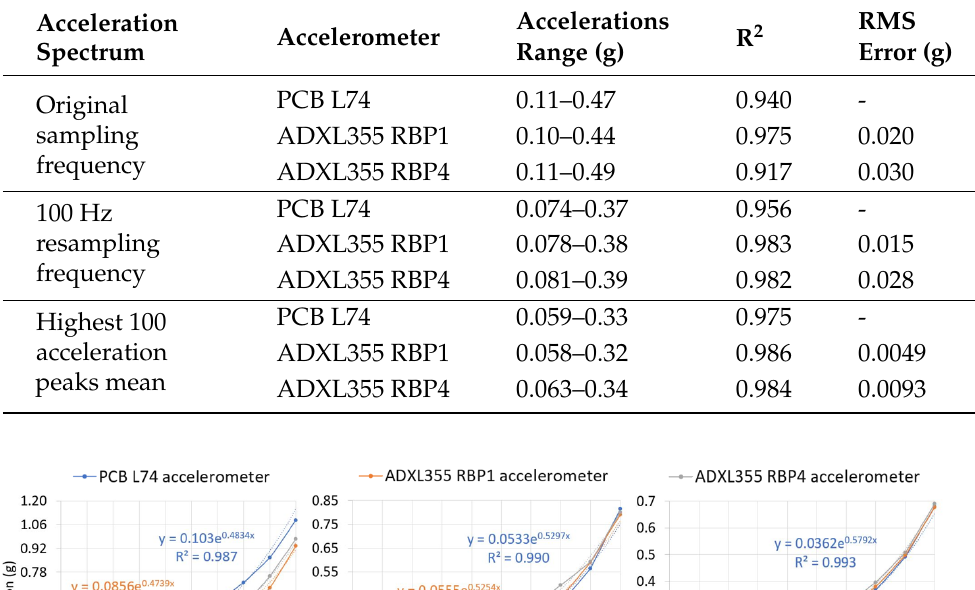
Table 4. Summary of the results obtained from the 0.25 cm displacement frequency chirp.